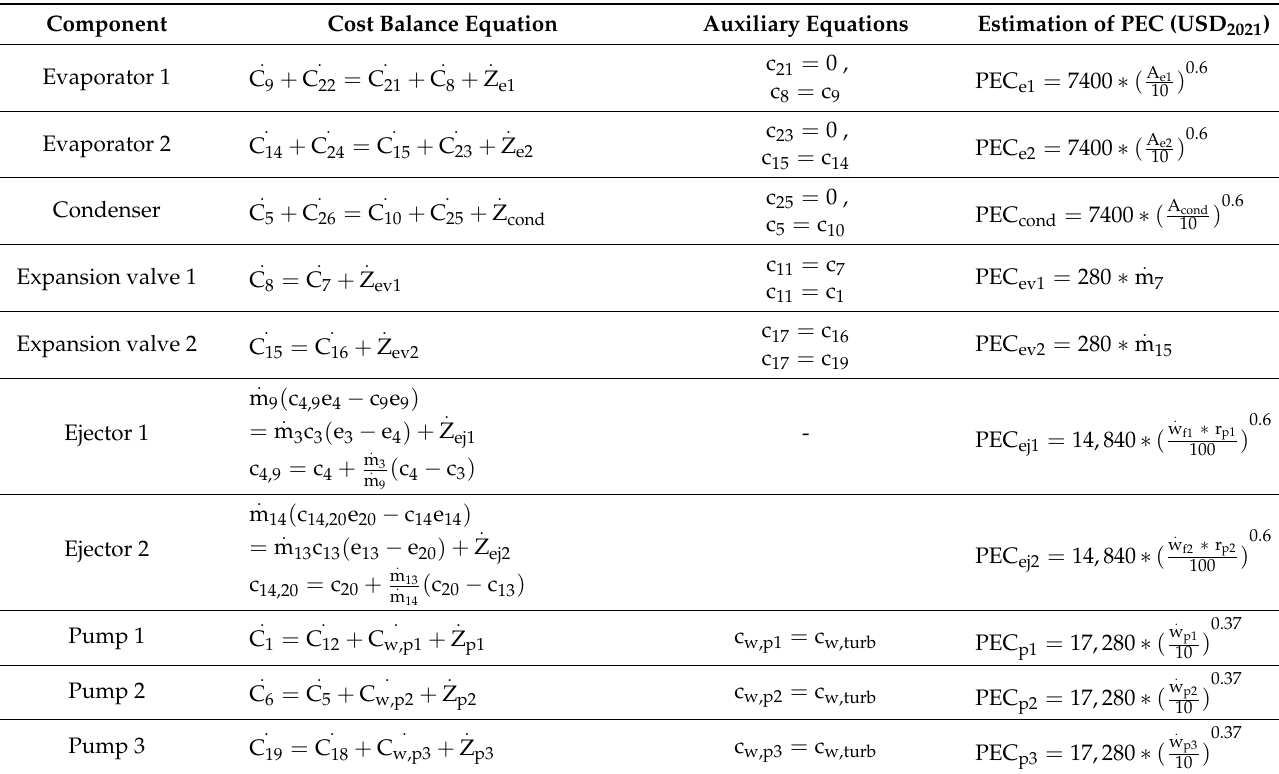
Table 4. Cost balance equations for the system